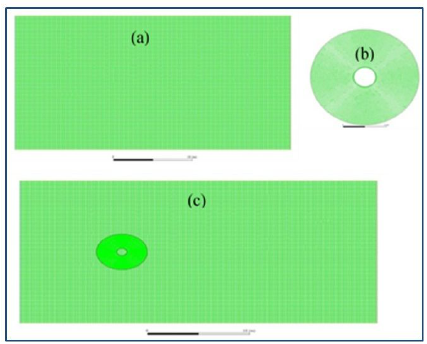
Figure 2: (a) Overset background mesh, (b) Overset component mesh, and (c) Overlapping background and component meshes